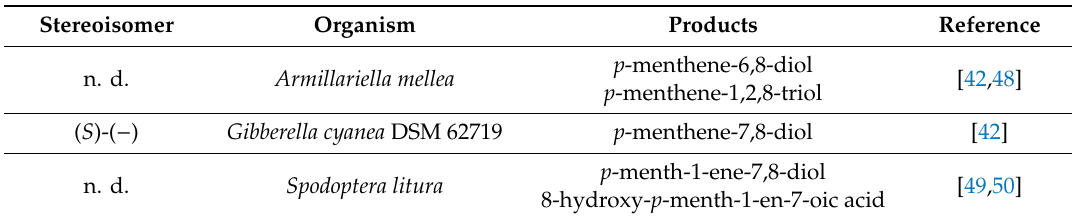
Table 5. Biotransformation of α -terpineol.